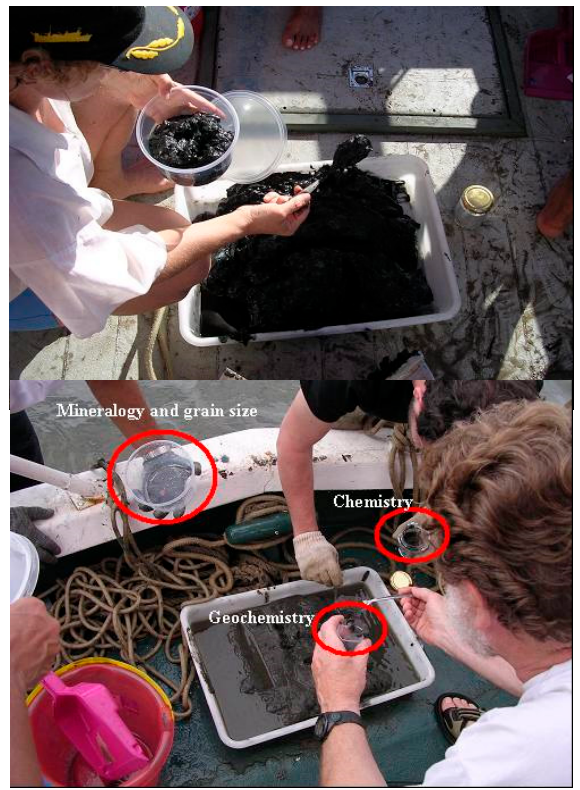
Figure 3. Storage of sediment samples depended on the type of analysis to be performed later on.